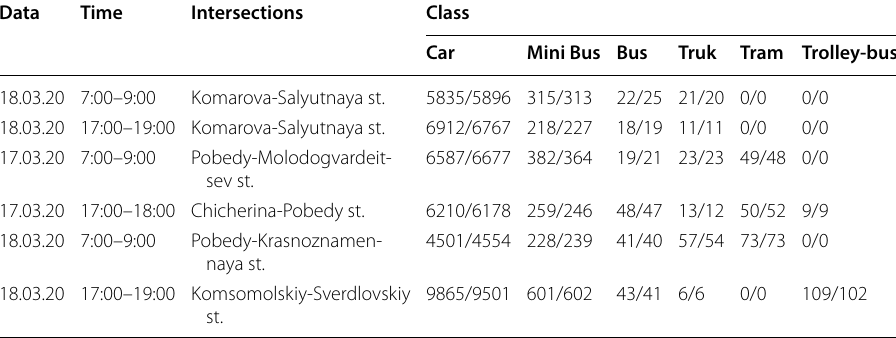
Table 3 Counting of vehicles at four intersections Data